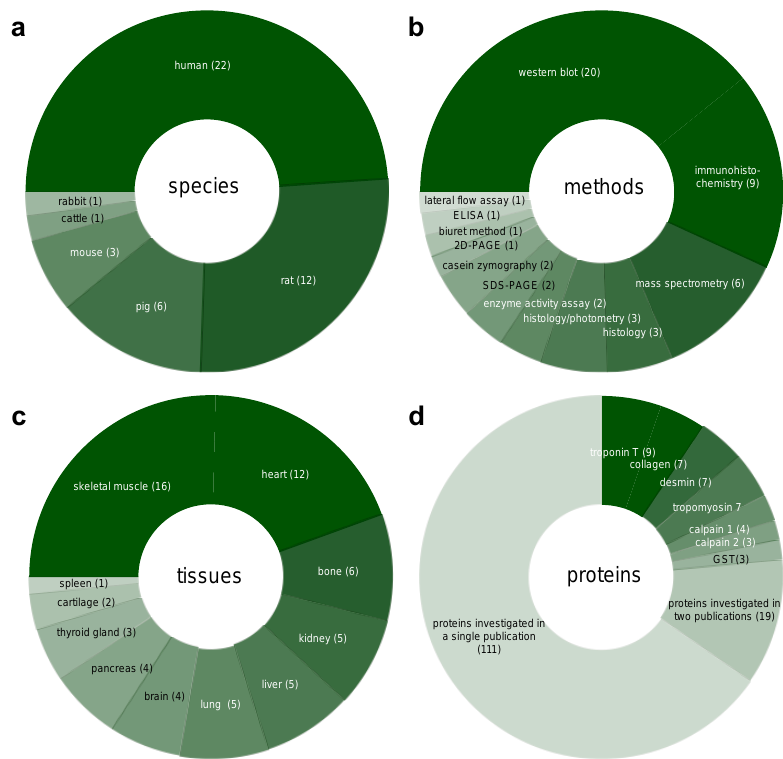
Figure 2. Frequency diagrams of analyzed species ( a ), methods ( b ), tissues ( c ), and proteins ( d ) targeted in at least two studies. All investigated proteins are listed in Table